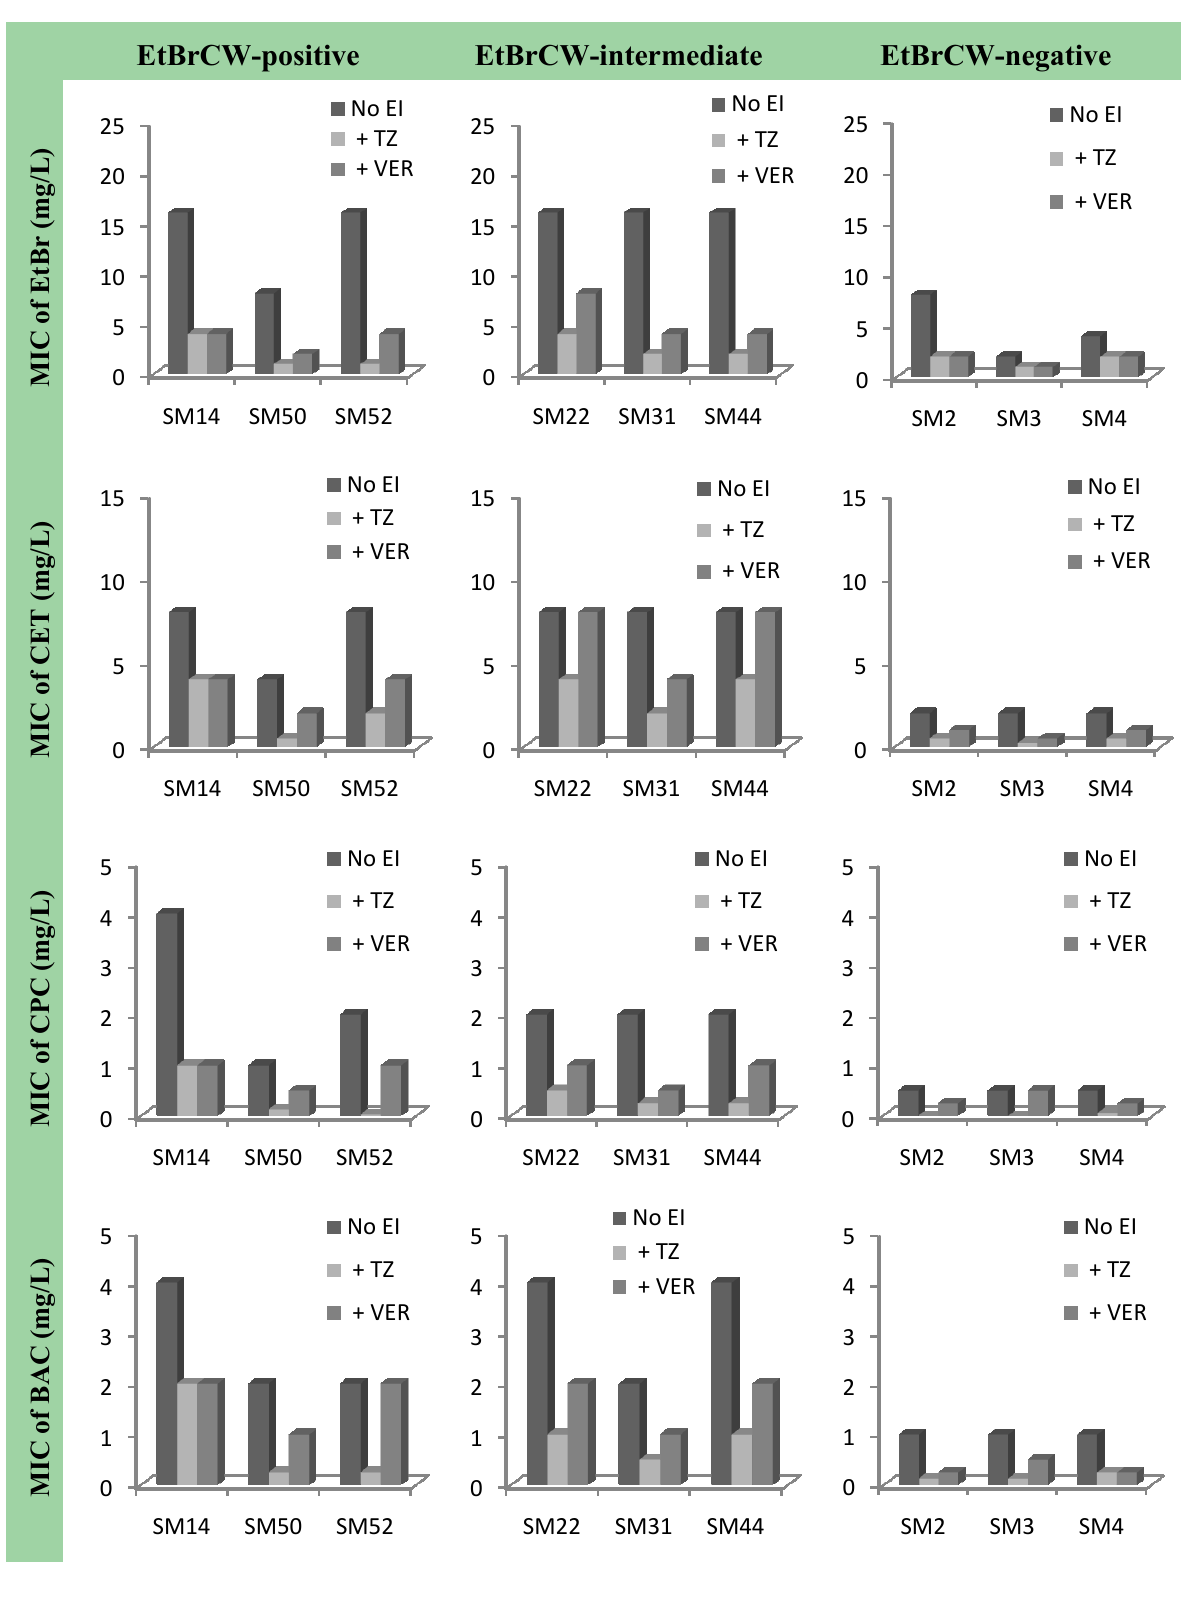
Figure 4. Effect of the efflux inhibitors thioridazine (TZ) and verapamil (VER), at subinhibitory concentrations (12.5 mg/L and 200 mg/L, respectively), on the MIC values of several biocides for representative isolates of the EtBrCW-positive, EtBrCW-intermediate and EtBrCW-negative